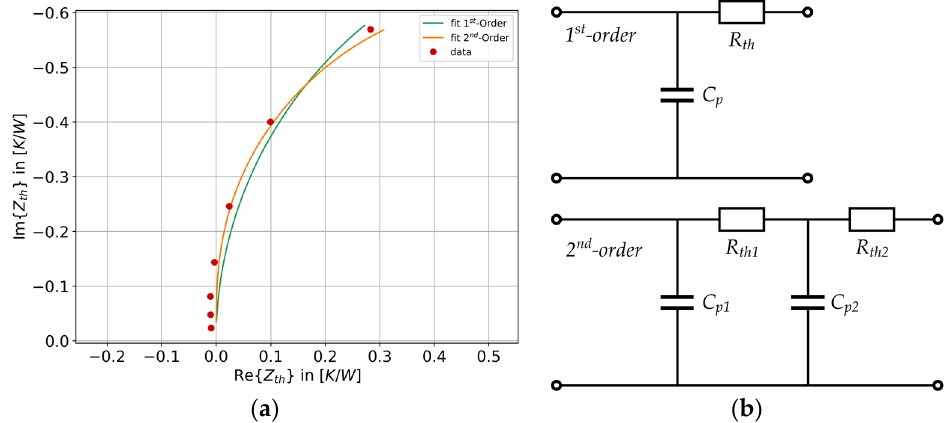
Figure 11. Comparison of calculated data points and the resulting model fit. ( a ) Nyquist plot. ( b ) Representation of first-order Cauer model (top) and second-order Cauer model (bottom).